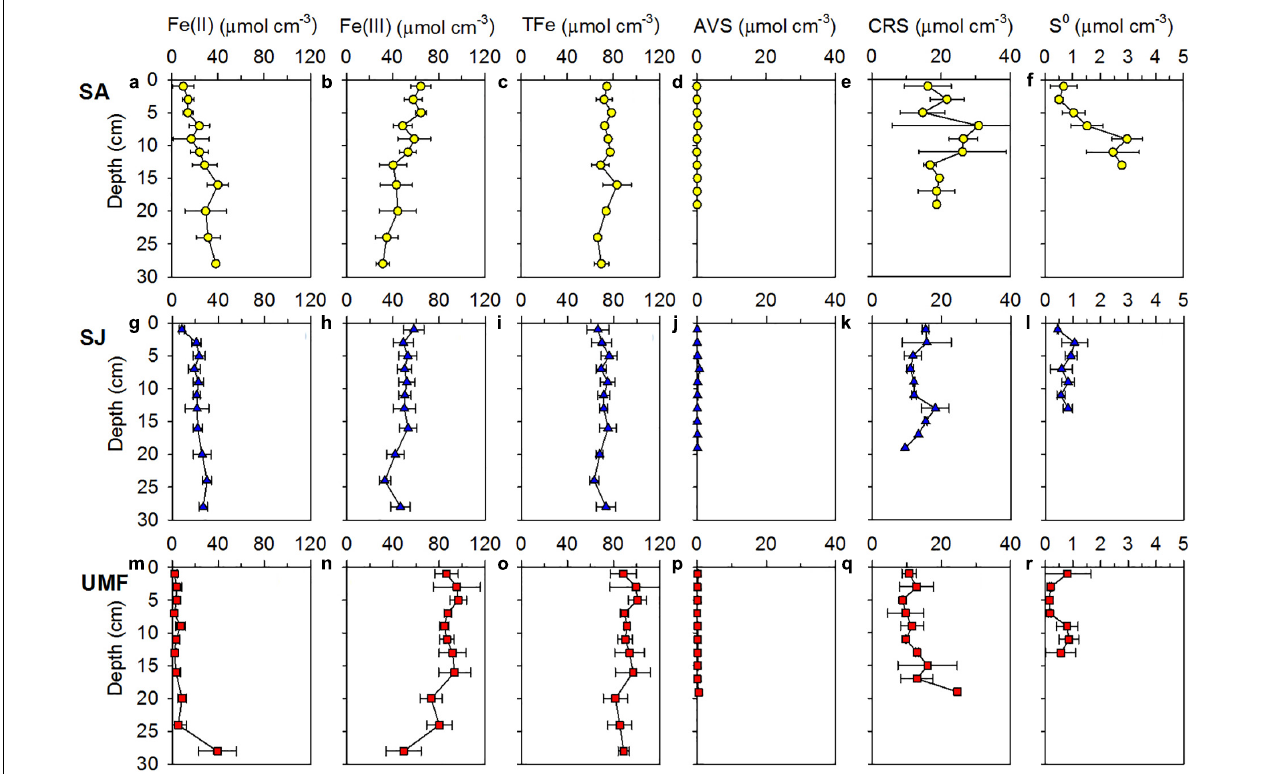
FIGURE 4 | Vertical profiles of oxalate-extractable Fe(II) (a,g,m) , Fe(III) (b,h,n) , total Fe (TFe) (c,i,o) , acid-volatile sulfur (AVS) (d,j,p) , chromium-reducible sulfur (CRS) (e,k,q) , and elemental sulfur (S 0 ) (f,l,r) in sediment vegetated by Spartina anglica (SA) and Suaeda japonica (SJ) and unvegetated mud flats (UMF). Error bars indicate the mean ± 1 SD from duplicate or triplicate